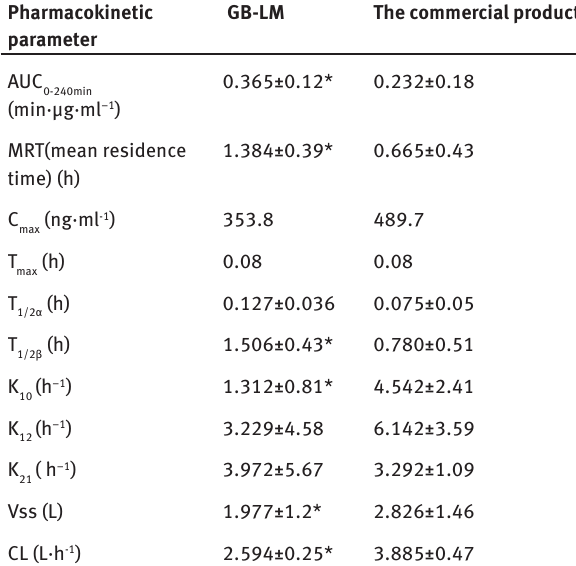
Table 8: Pharmacokinetic parameters of GB after intravenous administration of GB-LM and the commercial product at a dose of 4 mg/kg as GB in rats.